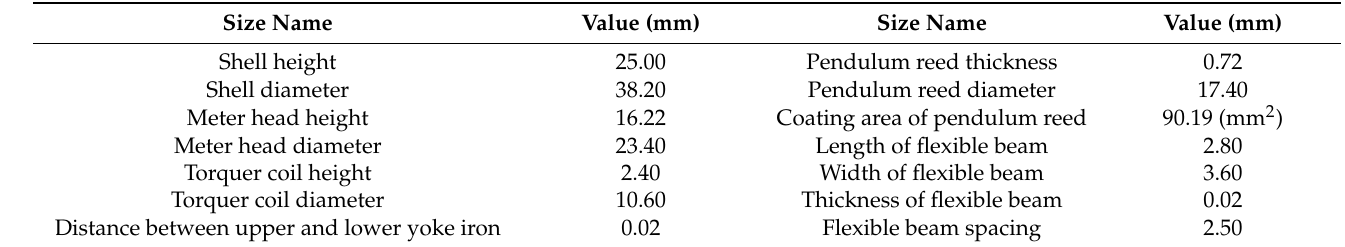
Table 3. Main geometric dimensions of QFA.